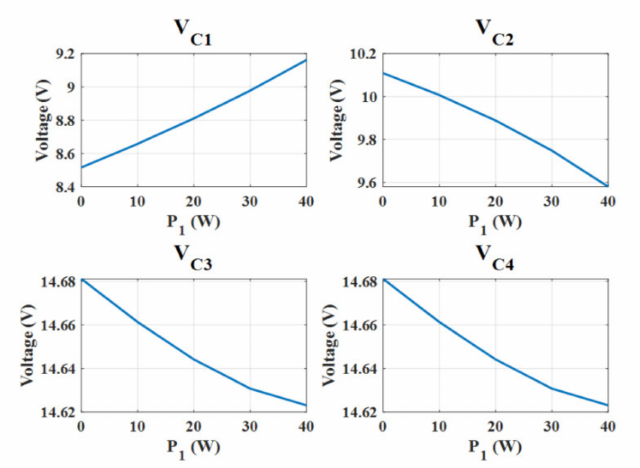
Figure 17. Voltage changes of the boost converters’ output capacitor connected to fuel cell stacks in closed-loop by changing the injected power of the first stack while the second stack injects 50 W and the other stacks inject the nominal power of 126 W.